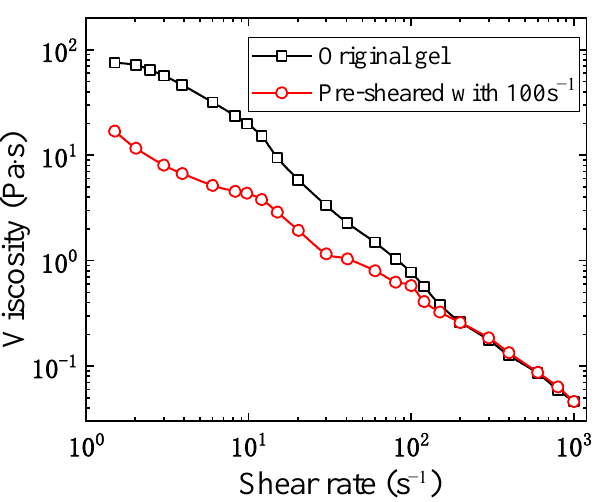
Figure 5. Viscosities of pre − sheared and non − pre − sheared kerosene gel under different shear rates.